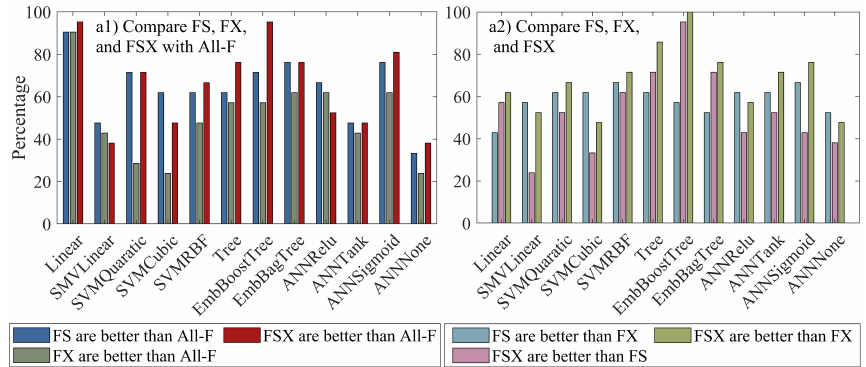
Figure 4. Percentage of FS-, FX-, and FSX-based models outperforming All-F-based models ( a1 ); FS-based models being better than FX-based models, FSX-based models being better than FS-based models, and FSX-based models being better than FX-based models ( a2 ).